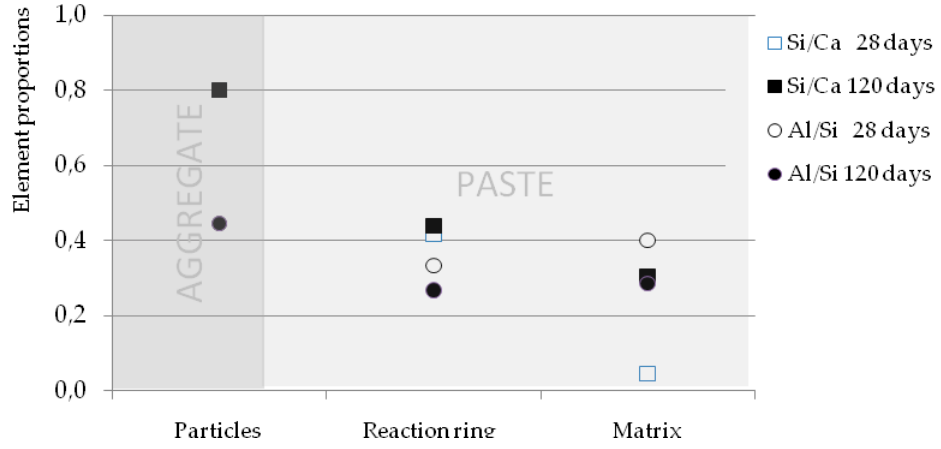
Figure 9. Element proportions of Al/Si and Si/Ca in the interface at 28 days and 120 days.